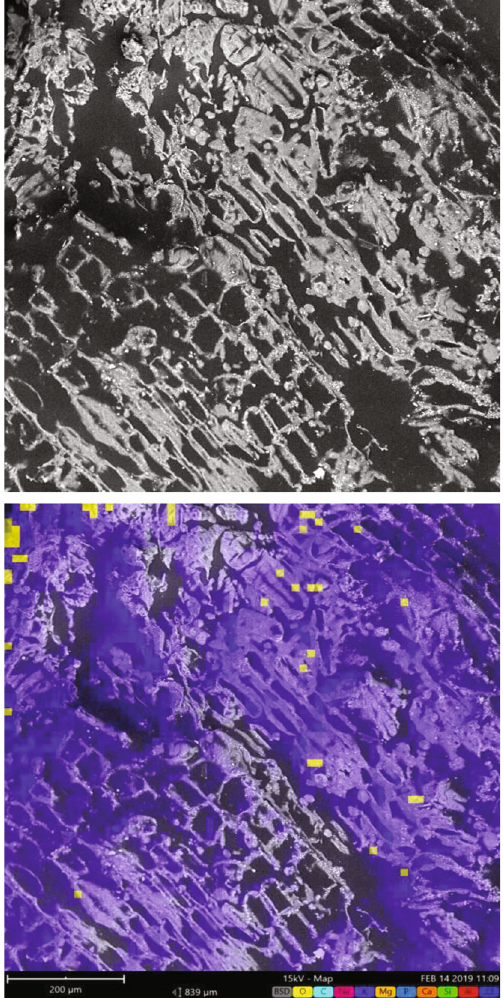
Figure 2: Micrograph of Colombian coastal Carimañolas obtained by atmospheric